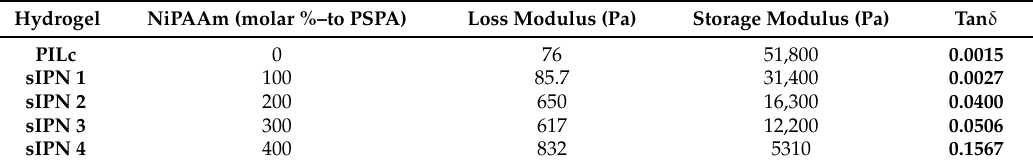
Table 2. Loss and storage modulus of the hydrogels at 25 (cid:5) C after 180 s of white light irradiation. Hydrogel